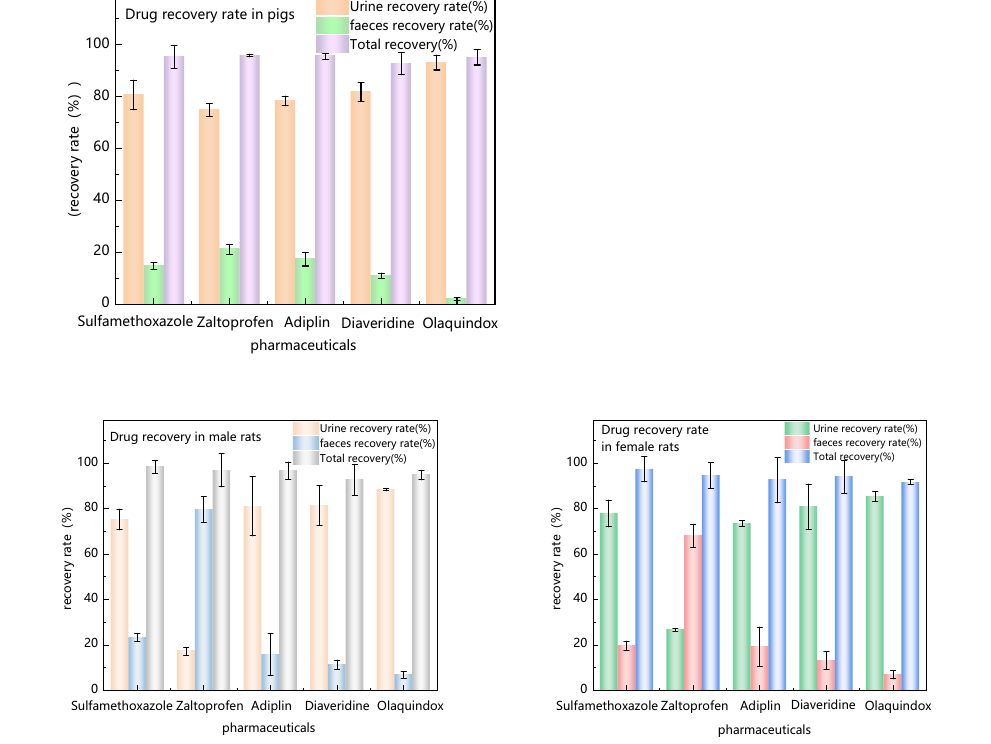
Figure 2. Drug recovery after intramuscular drug injection in different animals (data from [30–34]). Table 2. Drug recovery after intramuscular drug injection in different animals.